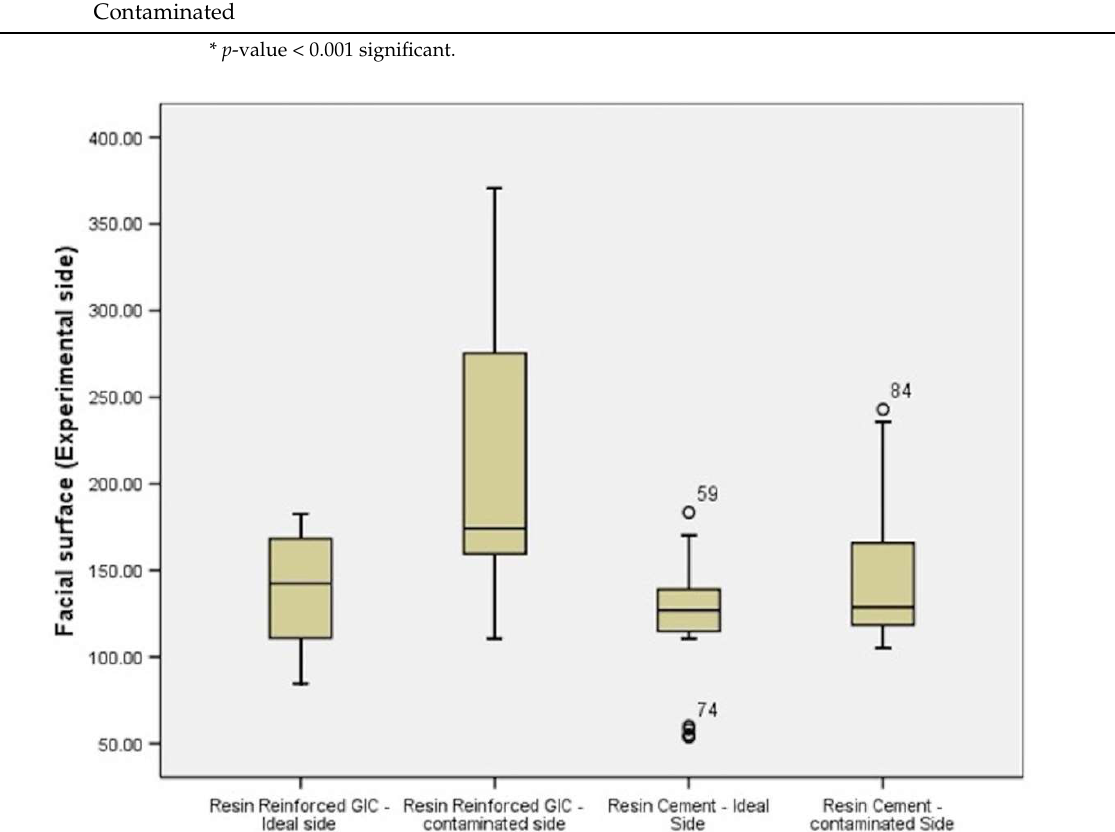
Figure 7. Box plot showing comparison of microleakage between different luting cements on experi- mental side of facial surface.